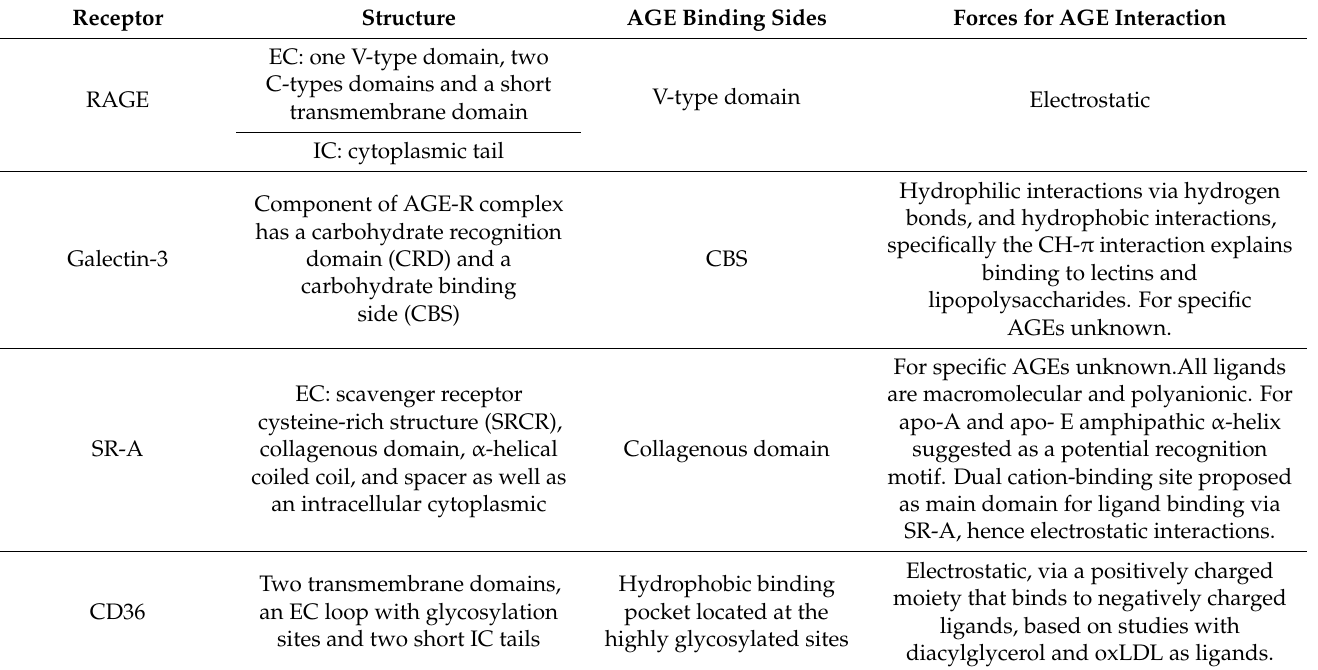
Table 1. Structural elements of AGE receptors that have been researched in relation to dAGEs: RAGE, galectin-3, SR-A and CD36: their role in AGE binding and the forces that result in the interaction of AGEs with the respective AGE